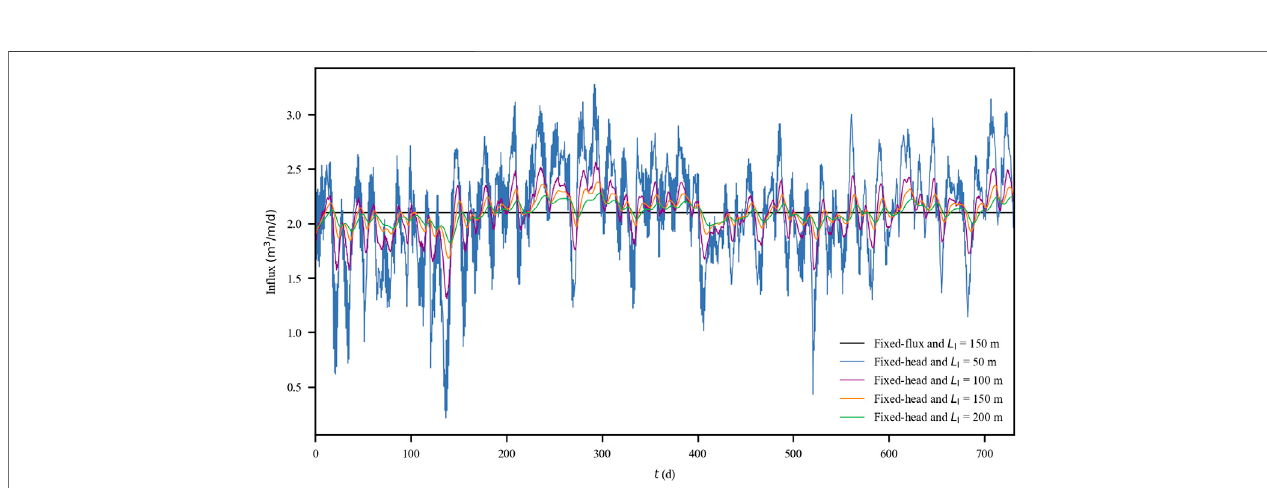
FIGURE 4 | Averaged inland freshwater input every 12.42 h for the cases with fi xed- fl ux ( L I (cid:1) 150 m) and fi xed-head ( L I (cid:1) 50, 100, 150, and 200 m) inland boundaries.